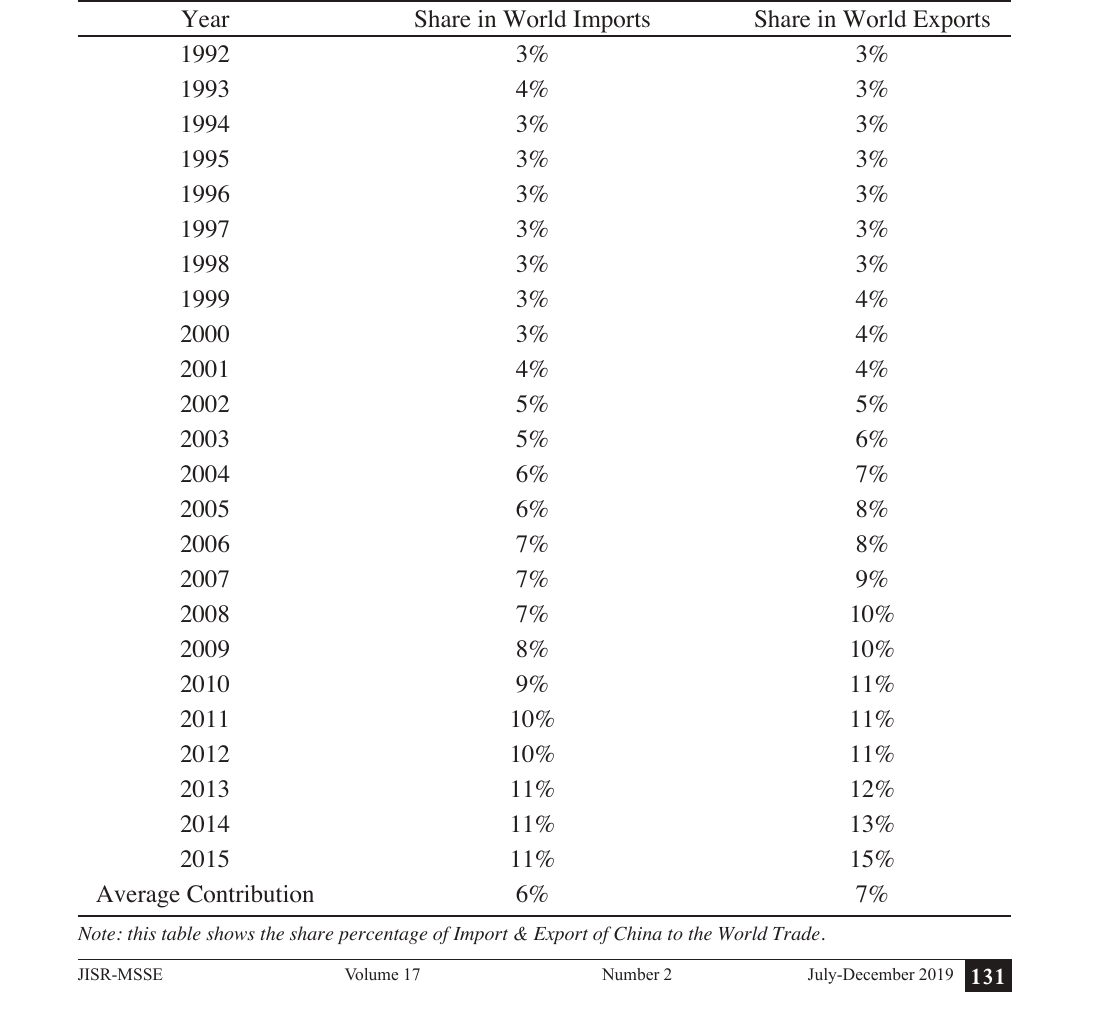
Share of Import & Export of China to the World Trade